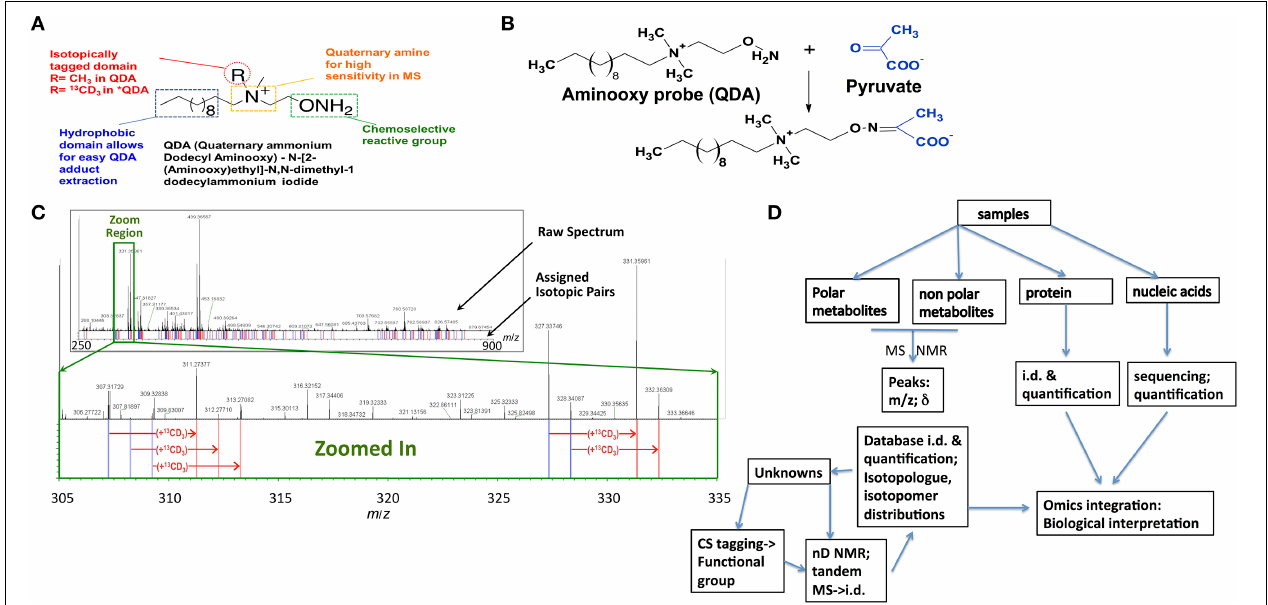
and 13 CD 3 -labeled QDA derivatives, giving a “bar-code” profile of the adduct pairs (adapted from Mattingly et al., 2012). (D) Flow diagram from sample through to data integration. Samples from various sources are extracted into separate fractions of polar and non-polar metabolites and proteins (single step, Fan, 2012) and nucleic acids, either genomic DNA or mRNA (Fan et al., 2012). The metabolites are either separated by chromatography for MS (e.g., GC-MS, LC-MS) or subjected to direct infusion high resolution MS and NMR (Lane et al., 2008, 2009). The knowns are identified by comparison with standard databases (Fan and Lane, 2008; Lane et al., 2008). The unknowns may be identified using additional experiments including tandem MS and multidimensional NMR, especially if isotope enriched and where editing techniques can be used. Alternatively, the samples can be reacted with functional-group-specific reagents that introduce a tag that can be edited for by NMR, and imparts increased sensitivity in MS. This additional information is used to narrow down the possibilities in the database searches as described in the